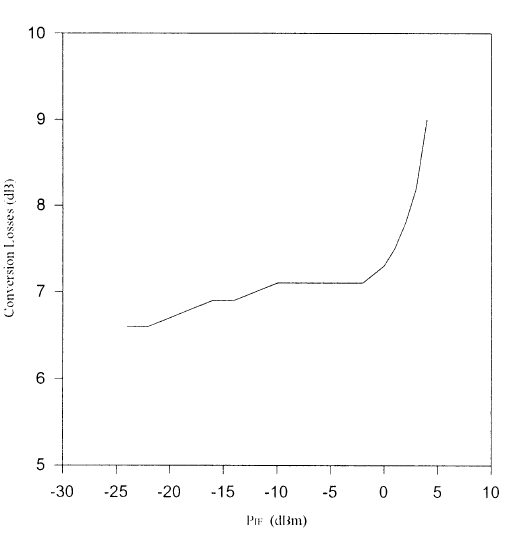
FIGURE 35 Conversion loss vs. the P IF